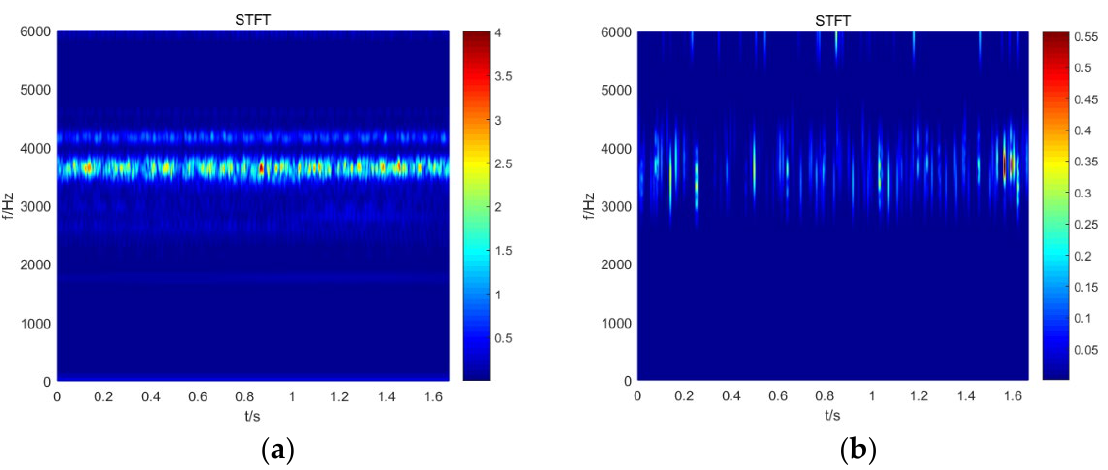
Figure 8. In 25 h: the STFT of ( a ) harmonic component; ( b ) impulse component.